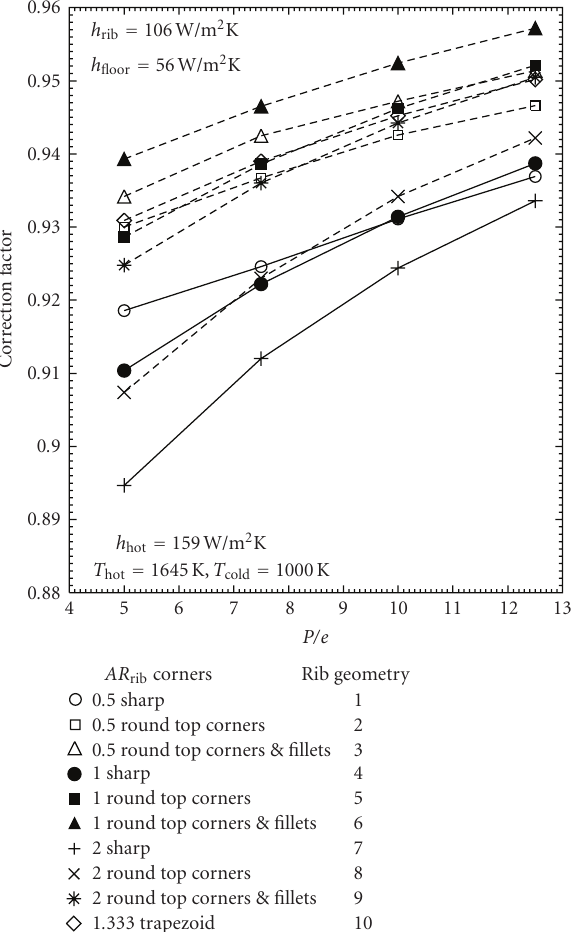
Figure 5: Correction factor variation with P/e